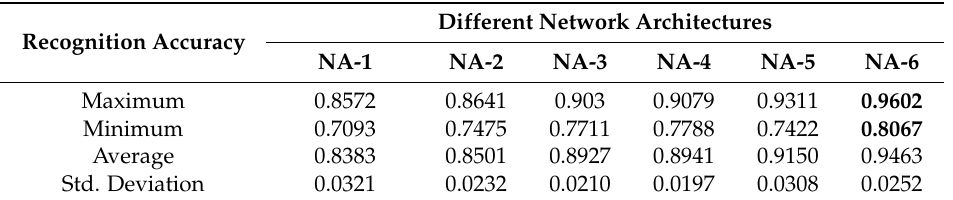
Table 4. In this table, we report the results in term of maximum, minimum, mean, and standard deviation recognition accuracy obtained with different network architectures on ISIDCHAR when the system trained for 50 epochs with the RMSProp optimizer. The best scores are in bold.